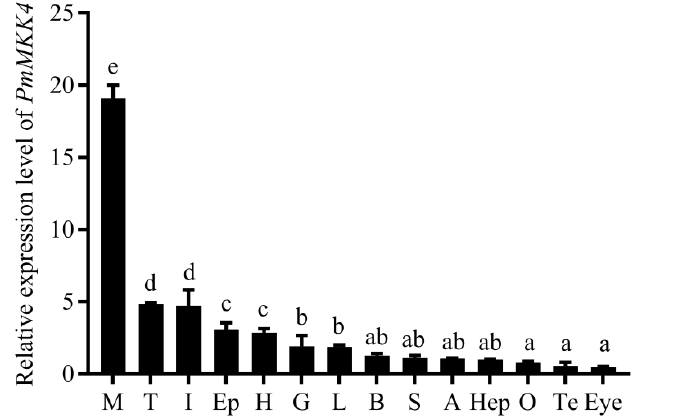
Figure 4. mRNA relative expression of PmMKK4 in different tissues. Abbreviations: M: muscle, T: